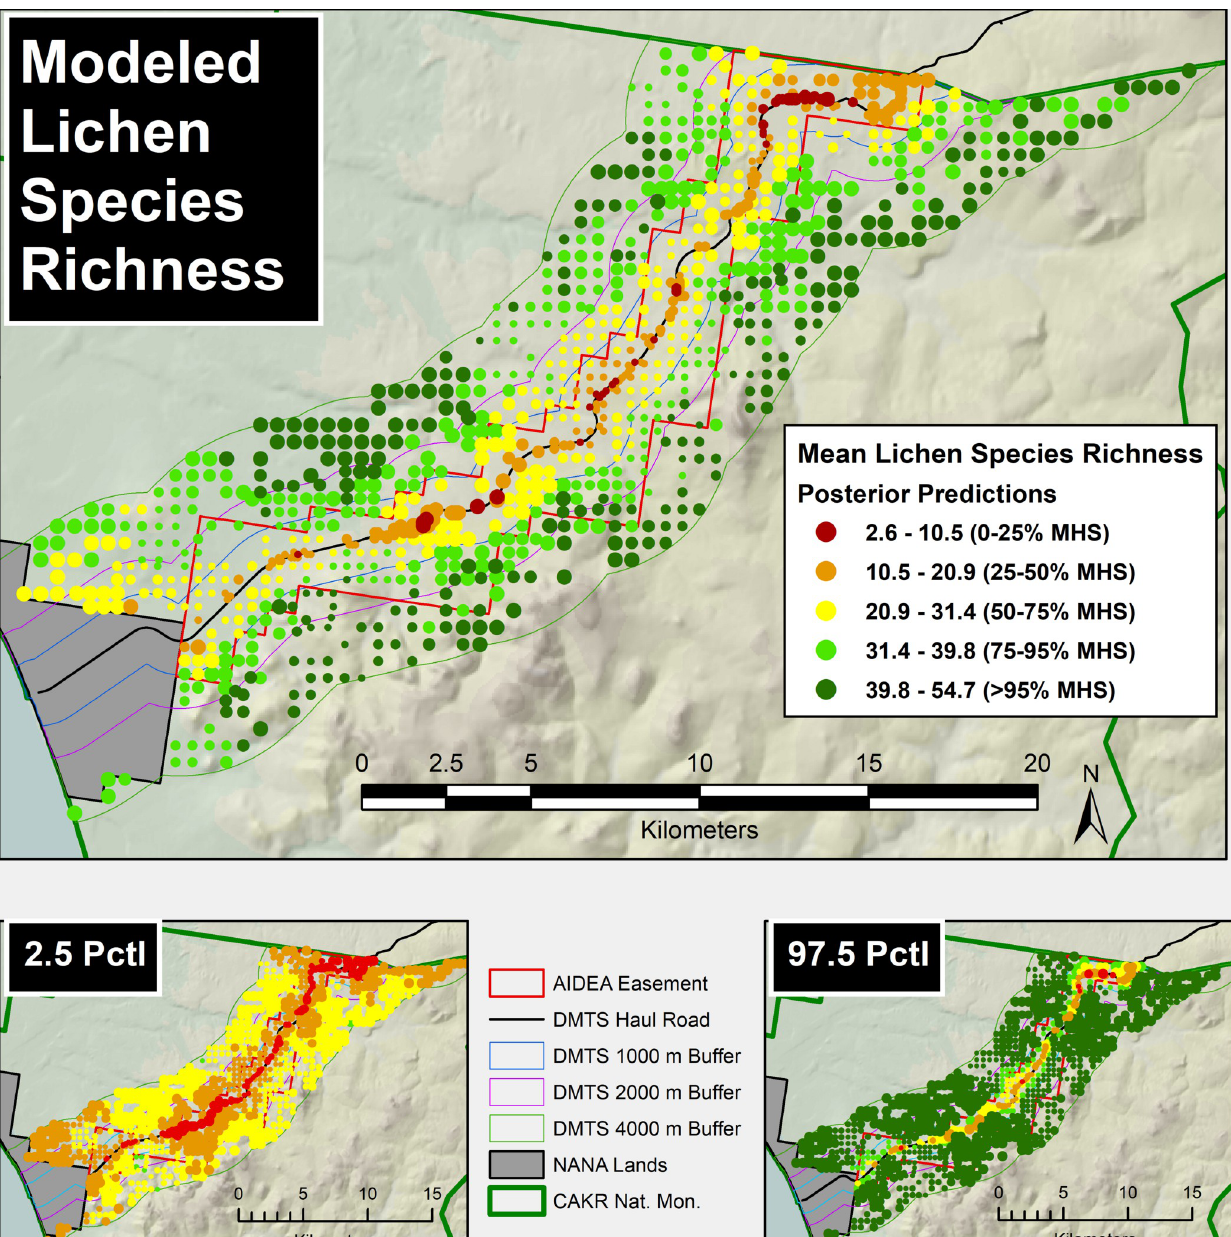
Fig 7. Modeled lichen species richness in a prediction grid from 0 to 4000 m from the DMTS haul road in Cape Krusenstern National Monument, Alaska. Prediction grid points are limited to those in the same land cover types as the study plots, as other land cover types have different lichen diversity and cover. Road buffer lines are drawn at 10, 50, 100, 300, 1000, 2000 and 4000 m. Points are sized proportionally in four classes by the quartile distributions of the reciprocal of the coefficient of variation (CV). The upper and lower bounds of the 95% confidence interval (i.e., 97.5 and 2.5 percentile values of the 200 simulations) are provided in small maps below the main